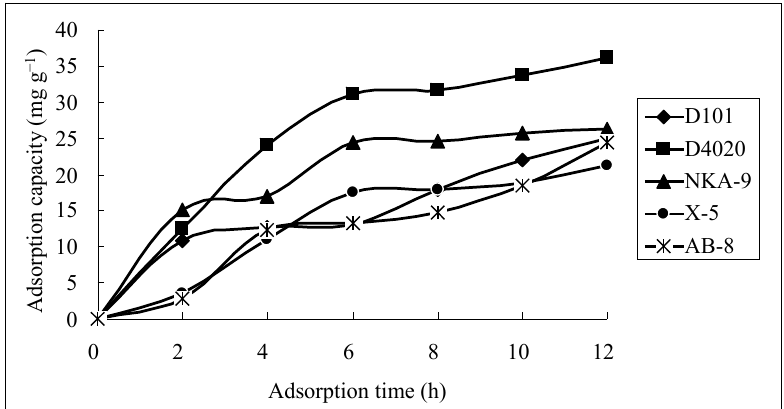
Figure 1. Adsorption kinetics curves for total flavonoids on different resins.